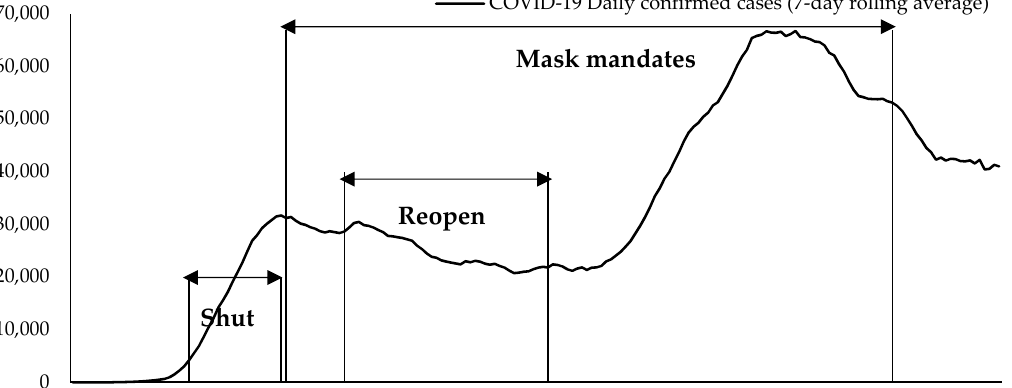
Figure 1. Policy implementation period and COVID-19 daily new infections, US. Note: earliest policy start date to latest policy start date across 50 US states. Source: author’s analysis of state policy using NY Times [1,26] and CNN data [31].